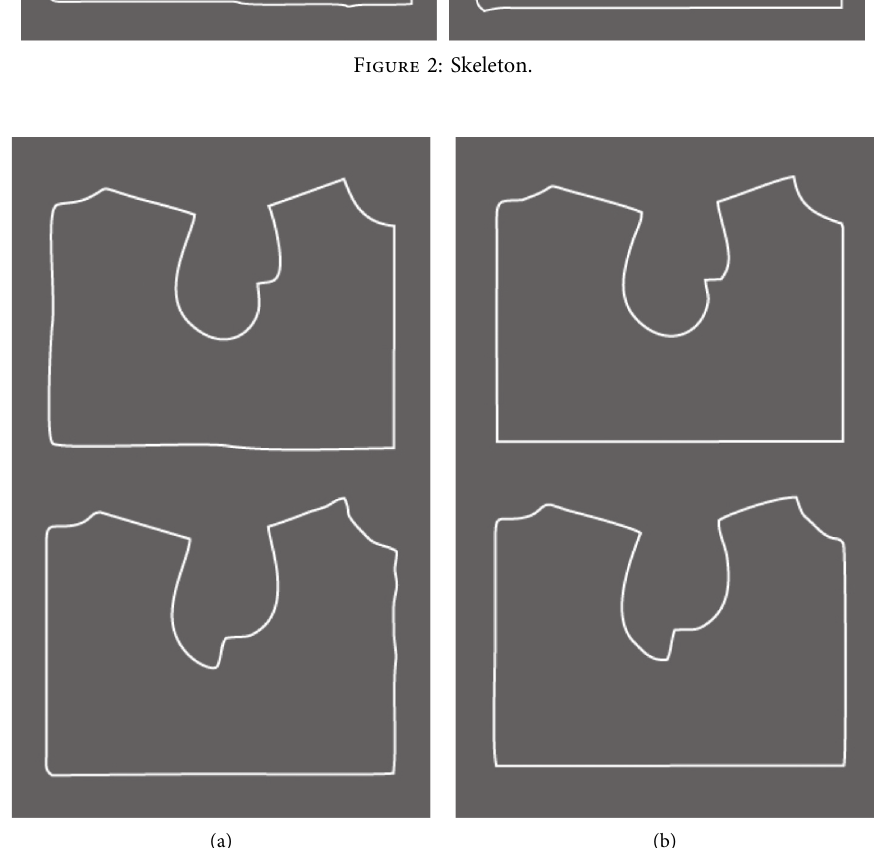
Figure 3: Model silhouette (b) after the model skeleton (a) and smooth